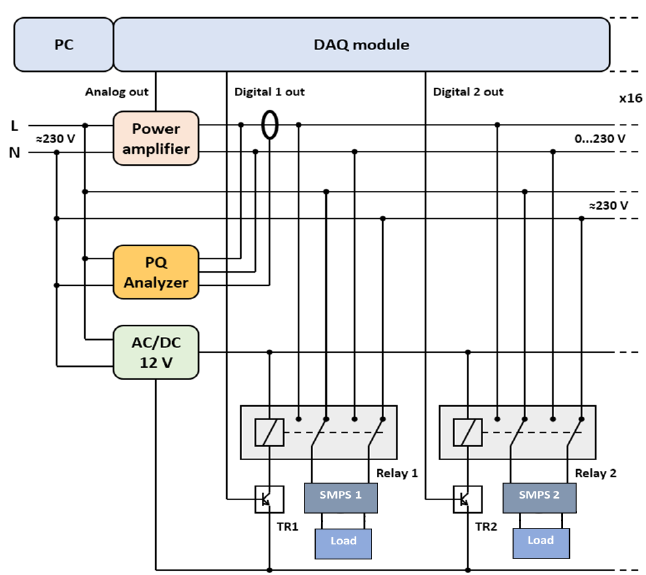
Figure 3. Block diagram of the measurement setup.